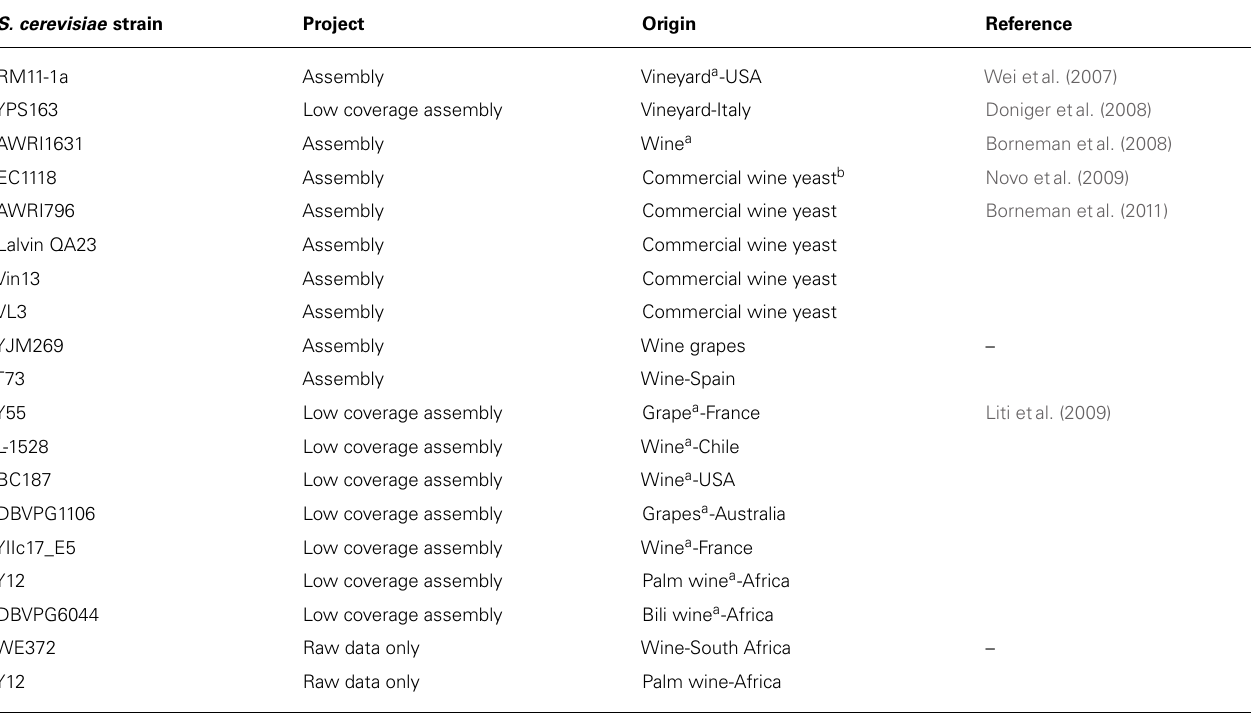
Table 1 | Sequenced genomes of wine Saccharomyces cerevisiae strains (modified from Borneman etal.,